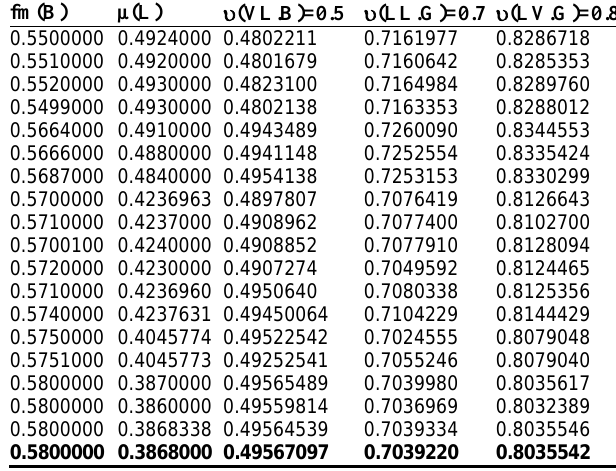
Table 2. 20 results with good